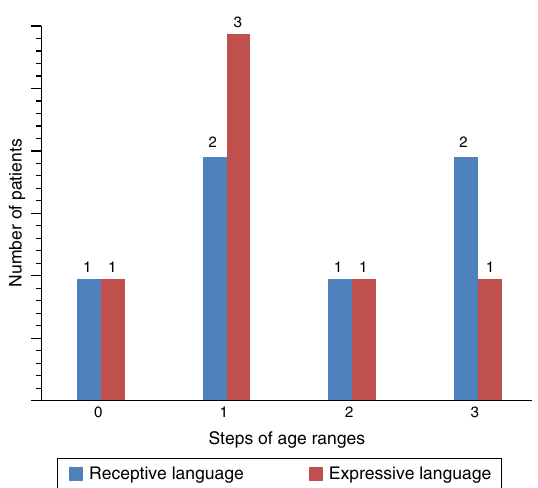
Figure 4 Results of auditory perception skills scores in ANSD with HA.